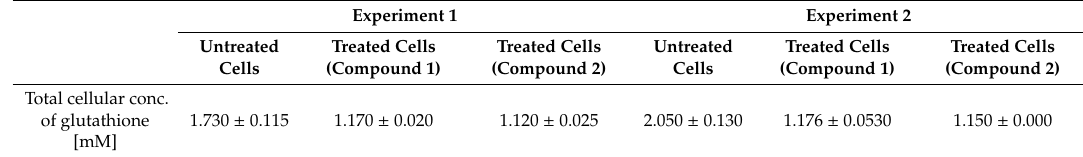
Table 2. E ff ects of treating BY4742 yeast cells with selenocyanates on the glutathione pool.